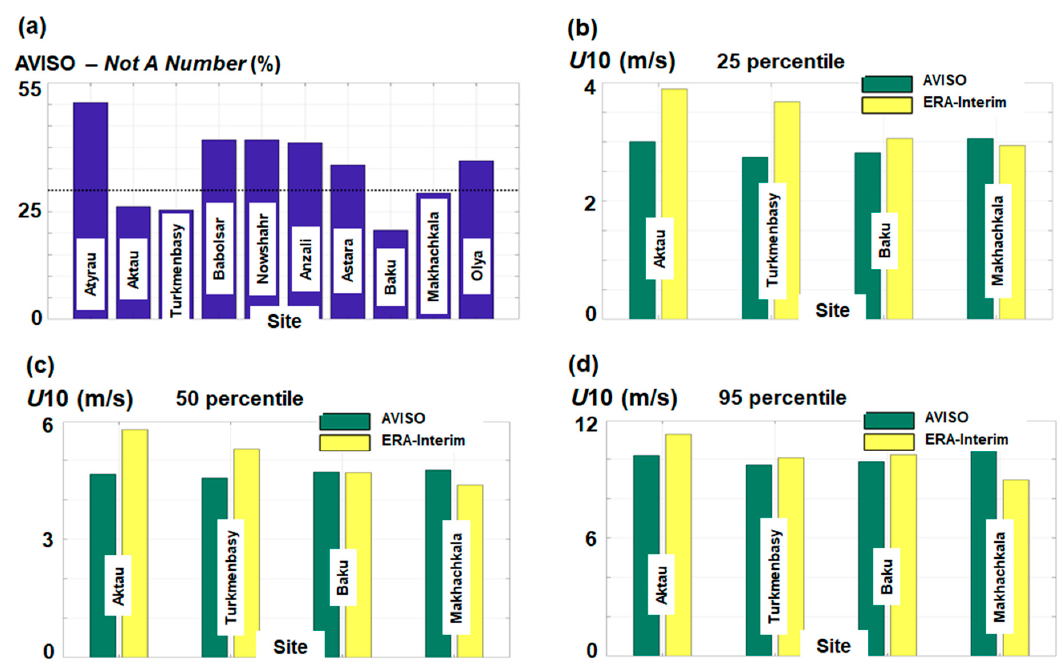
Figure 2. The comparisons between the AVISO measurements and the ERA–Interim reanalysis data for the time interval 2010–2017. The results are structured in: ( a ) NaN corresponding to the AVISO measurements; ( b ) 25 percentile; ( c ) 50 percentile; ( d ) 95 percentile.